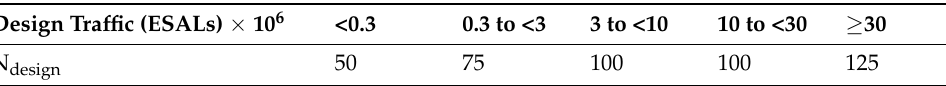
Table 13. Levels of design gyrations according to